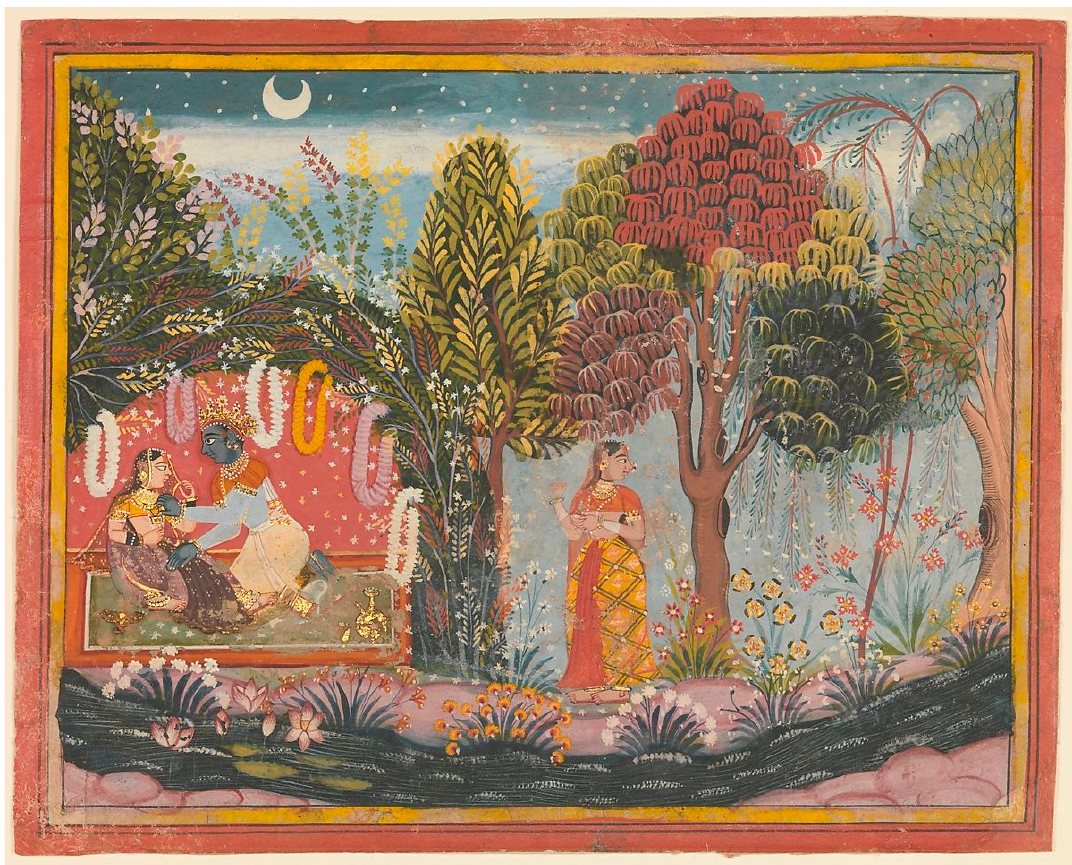
Figure 8. Krishna and Radha in a Bower: Page from a Dispersed Gita Govinda , Artist: Sahibdin, ca.